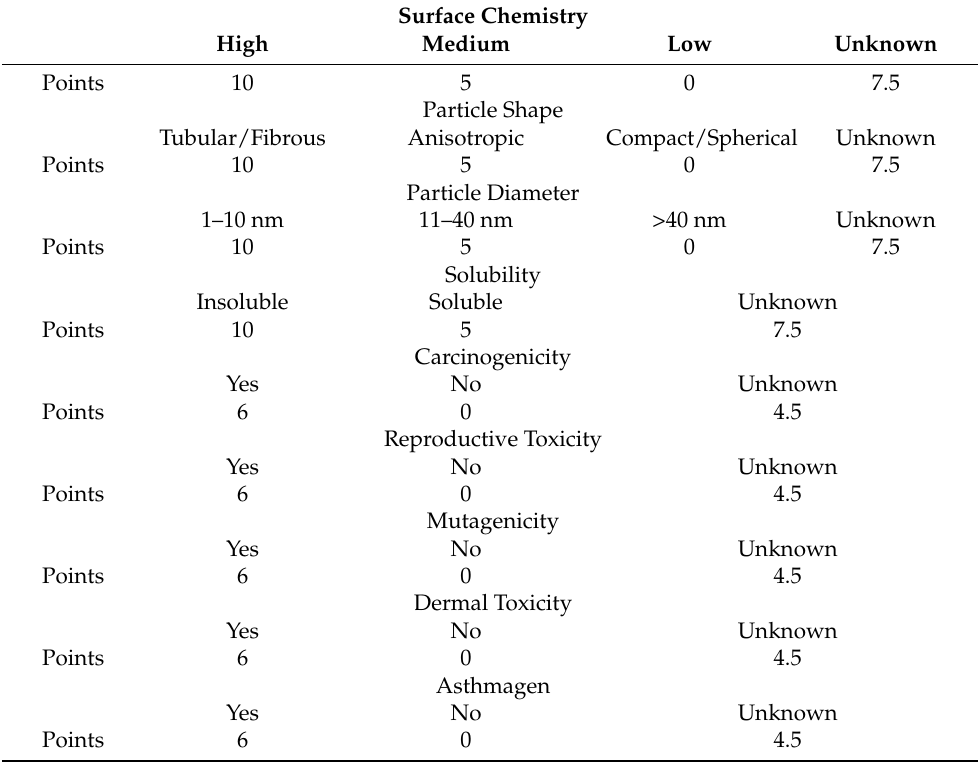
Table 3. Severity scores for incidental